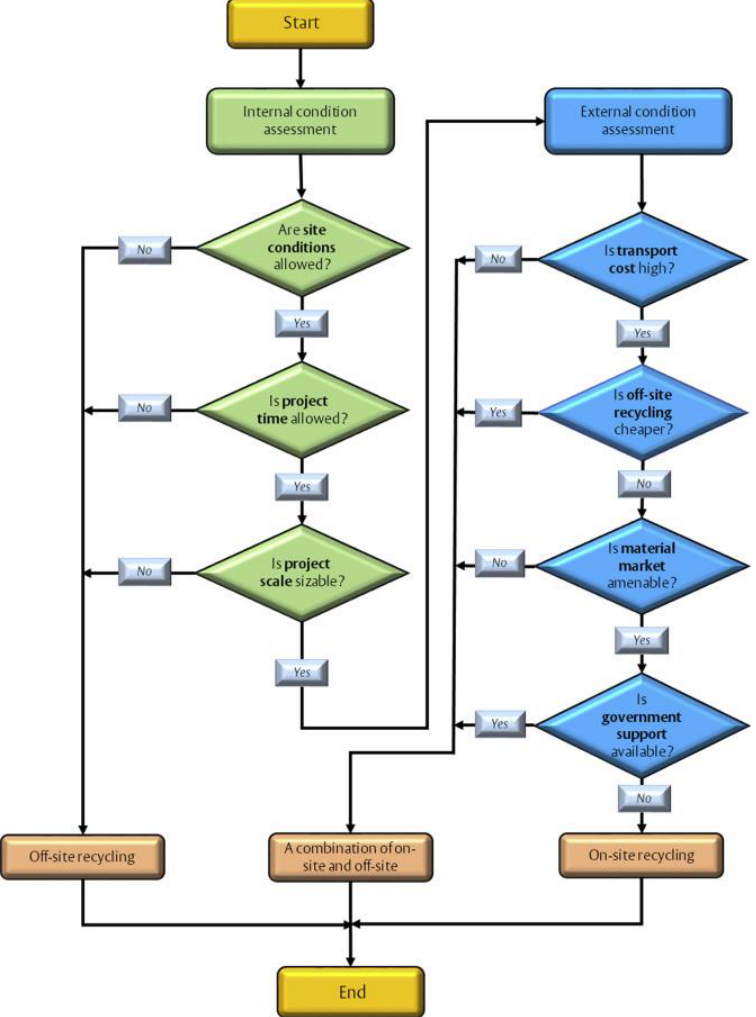
Figure 12. Decision-support framework for recycling C&D waste, adapted with permission from [38].